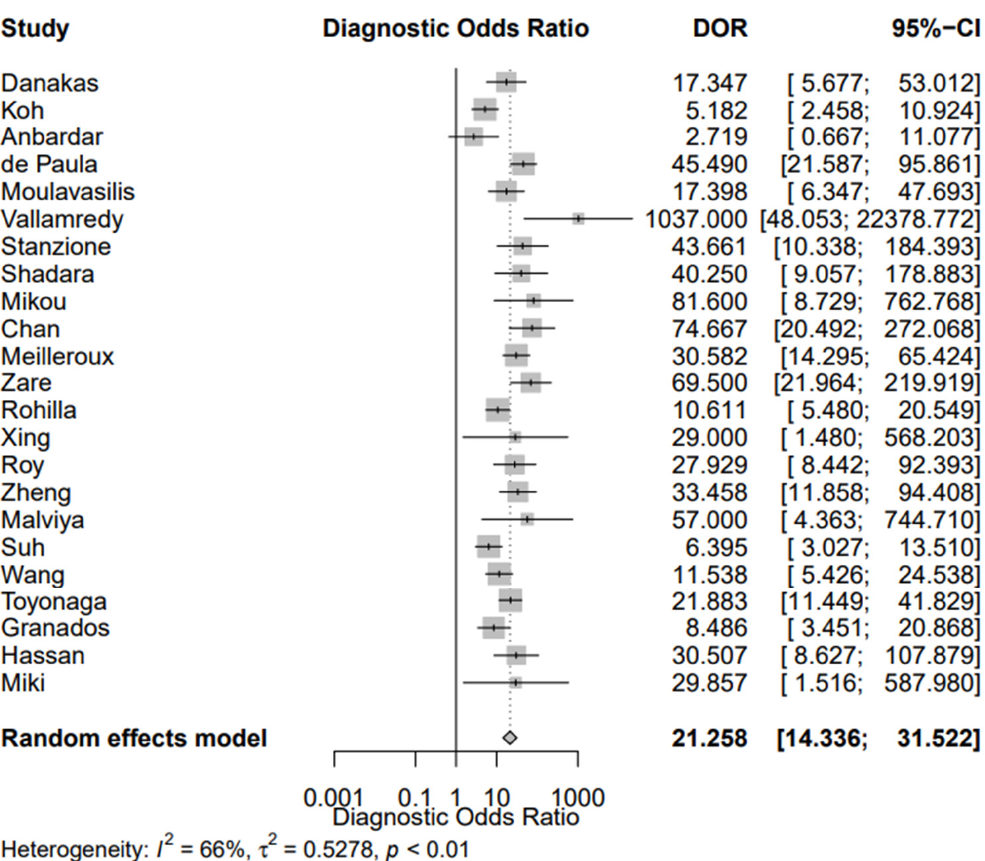
Figure 3. Diagnostic Odds Ratio (DOR) of the eligible studies.